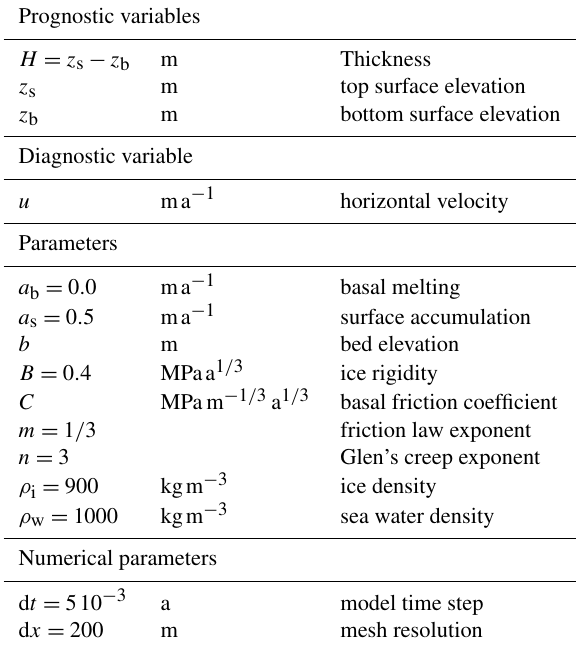
Table A1. Notations and values used in this study associated with the ice flow model.